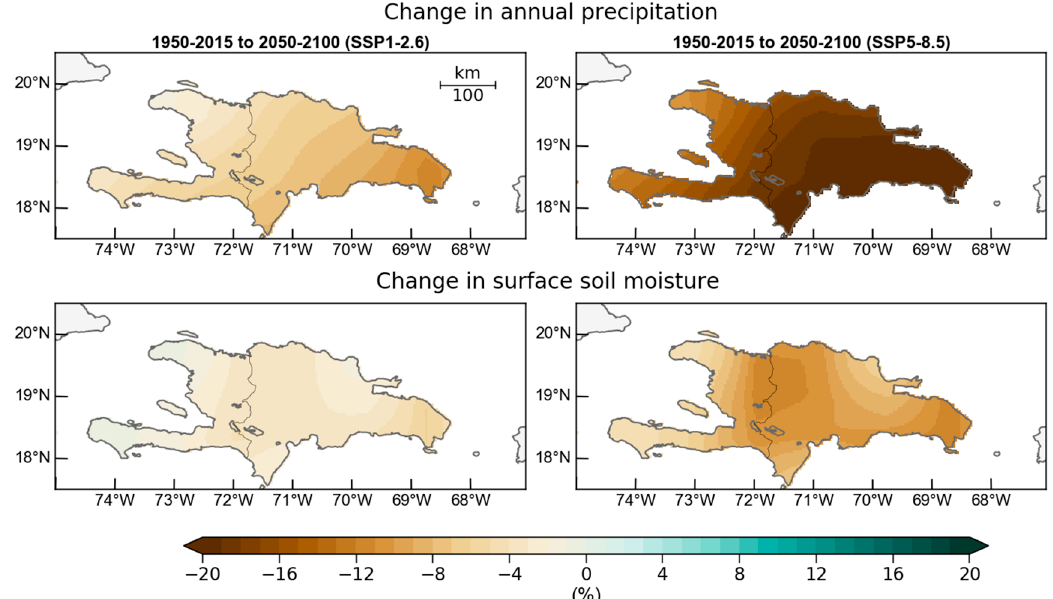
Figure 5. Multimodel means of the projected changes in precipitation and surface soil moisture on Hispaniola Island from CMIP6: Upper panels show the changes in the annual precipitation following the shared socioeconomic pathway (SSP) 1–2.6, which assumes a sharp decrease in greenhouse gas emissions in the left, and 5–8.5, which assumes the current emission rates of greenhouse gases in the right. For display purposes, we bilinearly interpolated the results to a common 0.04° × 0.04° (4 km) horizontal resolution to match with our high-resolution products.